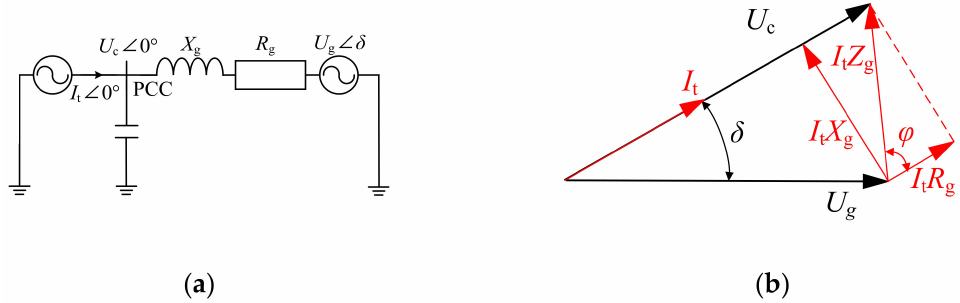
Figure 1. ( a ) Equivalent circuit diagram of the GFM converter; ( b ) phasor diagram of the GFM converter with unity power